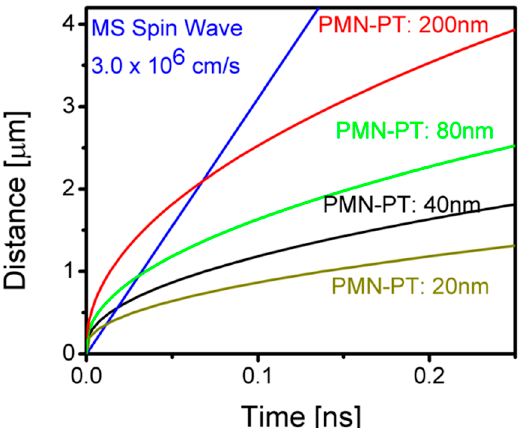
Figure 3. Results of numerical modeling illustrating the speed of signal propagation in the synthetic multiferroic interconnect. Shown are several curves corresponding to different thicknesses of the PMN-PT layer (20 nm, 40 nm, 80 nm, and 200 nm). The blue line is the reference data for the Magnetostatic Surface Spin Wave (MSSW) with a group velocity of 3.0 × 10 4 m/s.